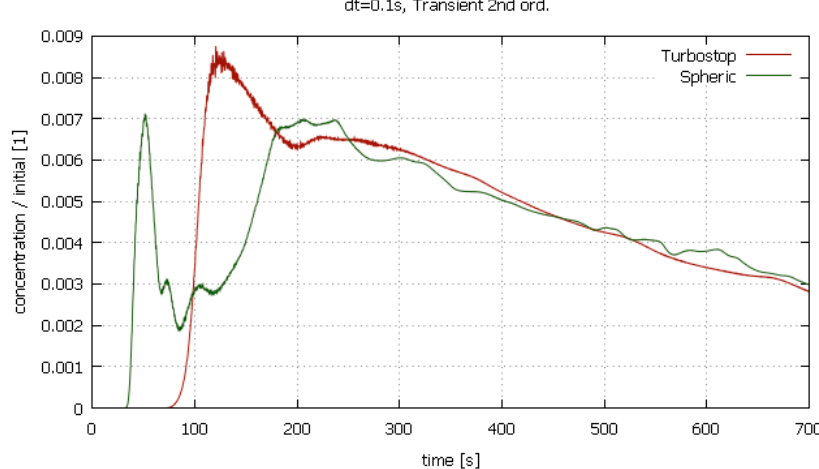
Figure 5. Comparison of C-curves for the “Spheric” impact pad and for standard impact pad @ 0.8 m · min − 1 —CFD simulation.